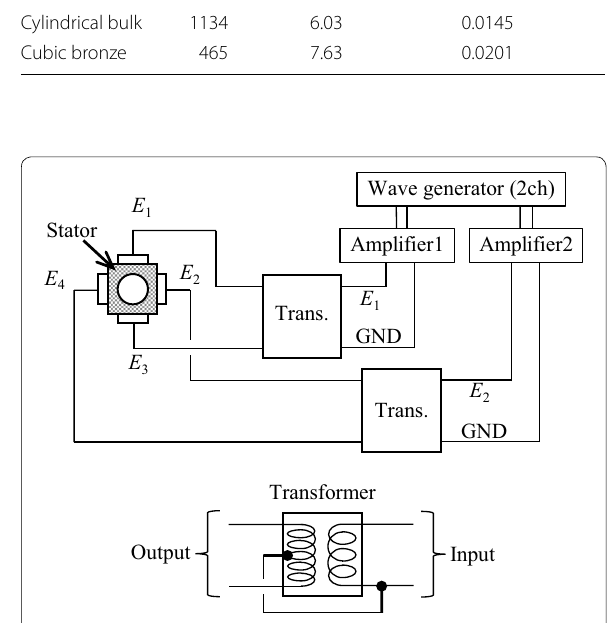
Fig. 7 Experimental setup to apply voltages to the